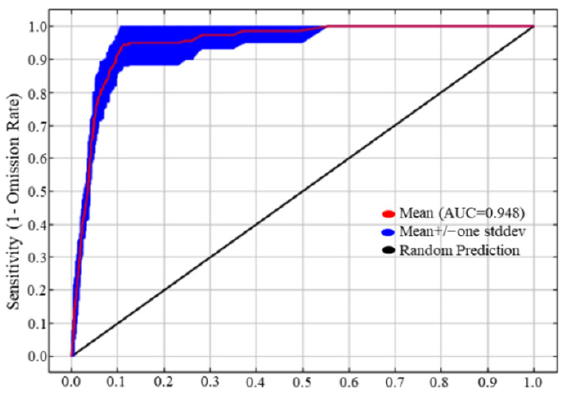
Figure 1. ROC curve of Maxent model.